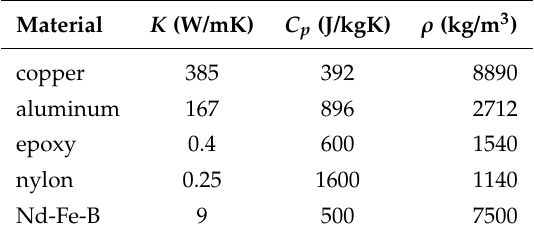
Table 1. Material